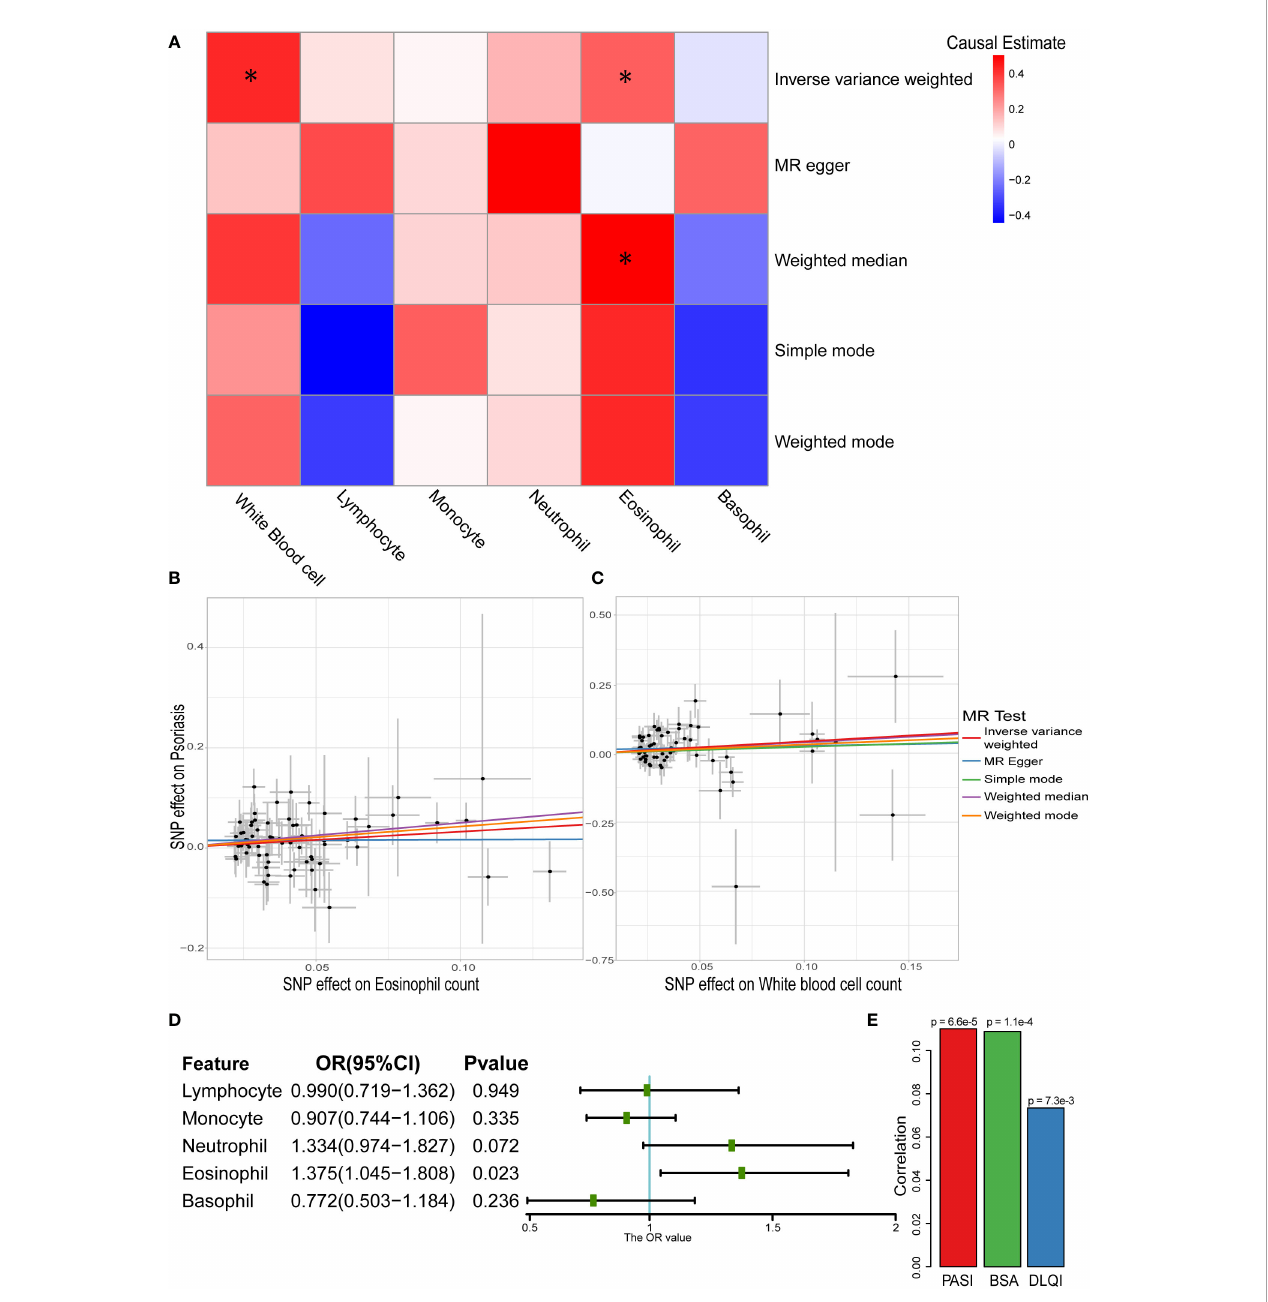
FIGURE 3 Causal relationship between white blood cells and psoriasis in two-sample MR analysis. (A) Heatmap of two-sample MR results about white blood cells and psoriasis (* represented P < 0.05). (B) Scatter plot of MR analysis related to eosinophil count and psoriasis. (C) Scatter plot of MR analysis related to white blood cell sum count and psoriasis. (D) Result of multivariable MR on different white blood cells and psoriasis. (E) Correlation between eosinophil count and severity of psoriasis (Spearman ’ s